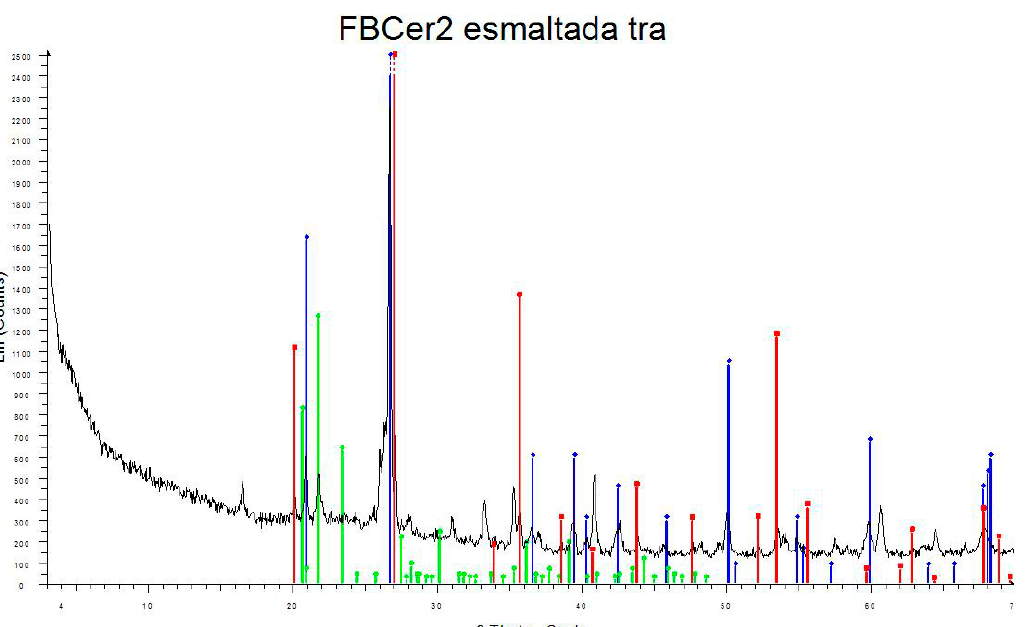
FBCer2 esmaltada tra - File: VEI15.raw - Type: 2Th/Th locked - Start: 3.000° - End: 70.000° - Step: 0.050° - Step time: 3. s - Temp.: 25 °C (Room)-Time Started: 16 s - 2-Theta: 3.000° - Theta: 1.500° - Chi: 0.00° - Ph